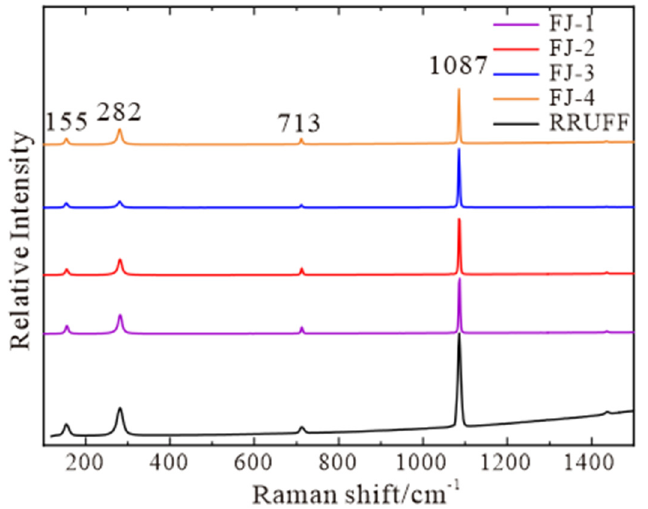
Figure 3. Raman spectra of FJ-1, FJ-2, FJ-3, and FJ-4, RRUFF standard spectra are listed for comparison.